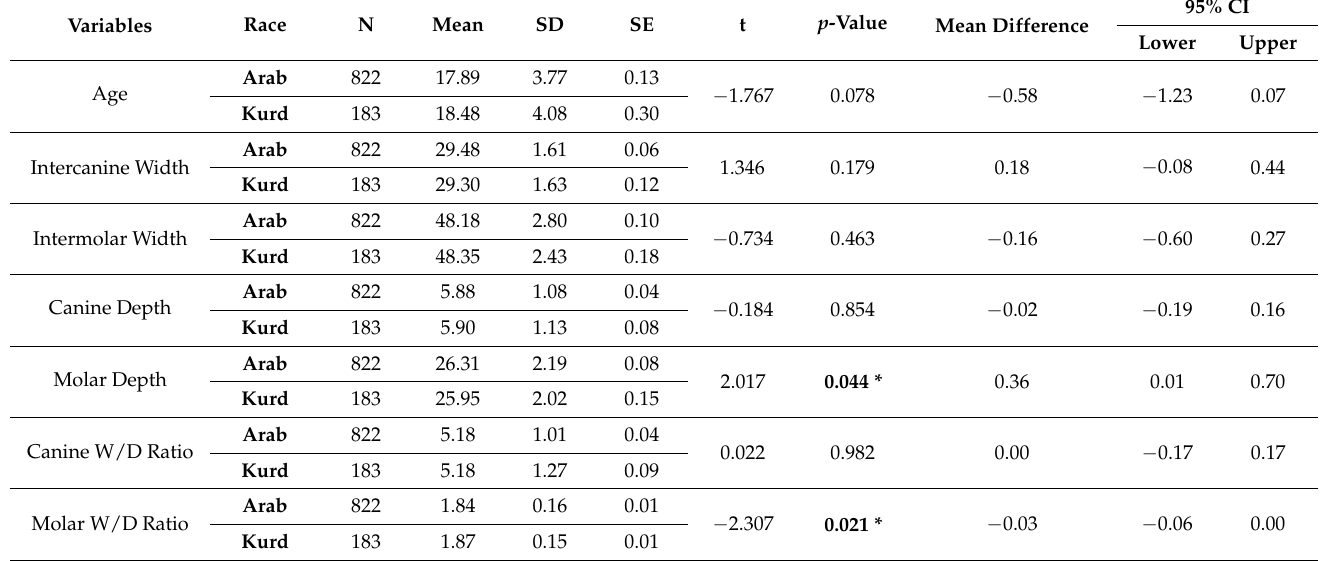
Table 5. Descriptive statistics and comparison of age and arch dimensions between races (independent samples t -test).